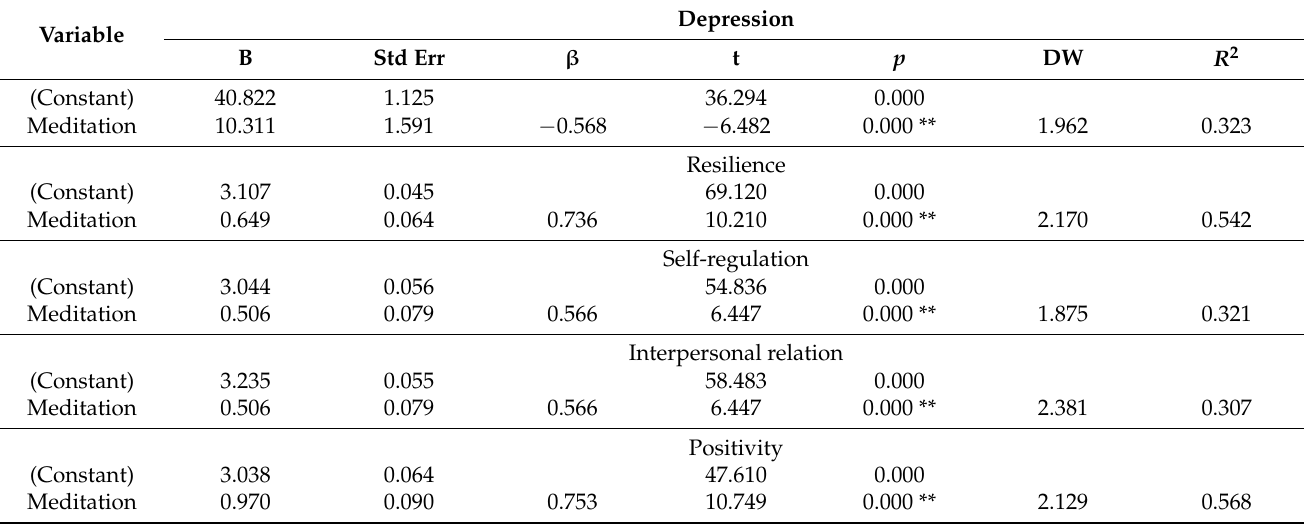
Table 5. Validity of meditation experience on